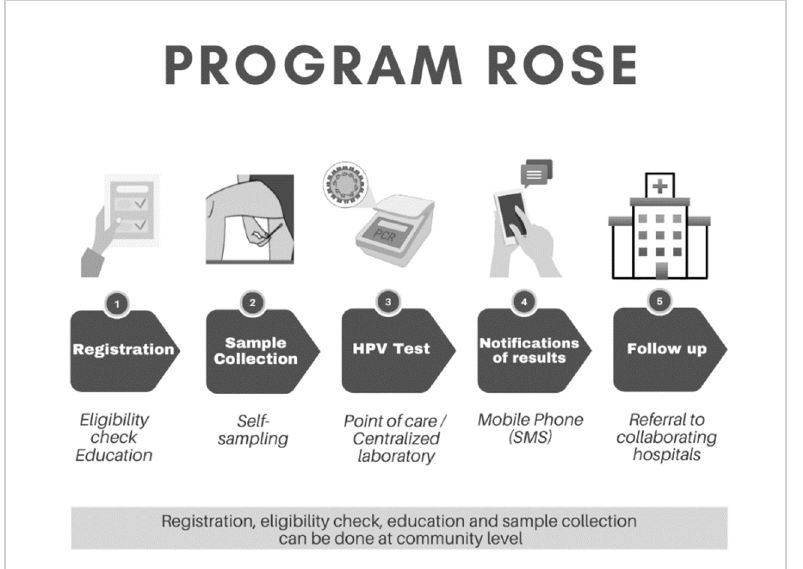
Figure 1. Overview of Program ROSE. Step 1–2 can be conducted in different settings such as